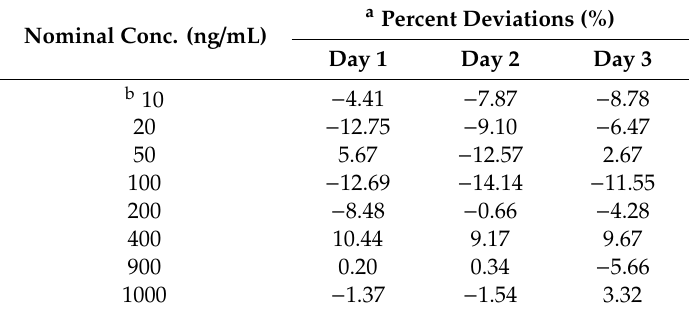
Table 1. Deviations from the experimental standard sesamol concentration range (10 to 1000 ng / mL). Data are represented as percent deviations ( n =